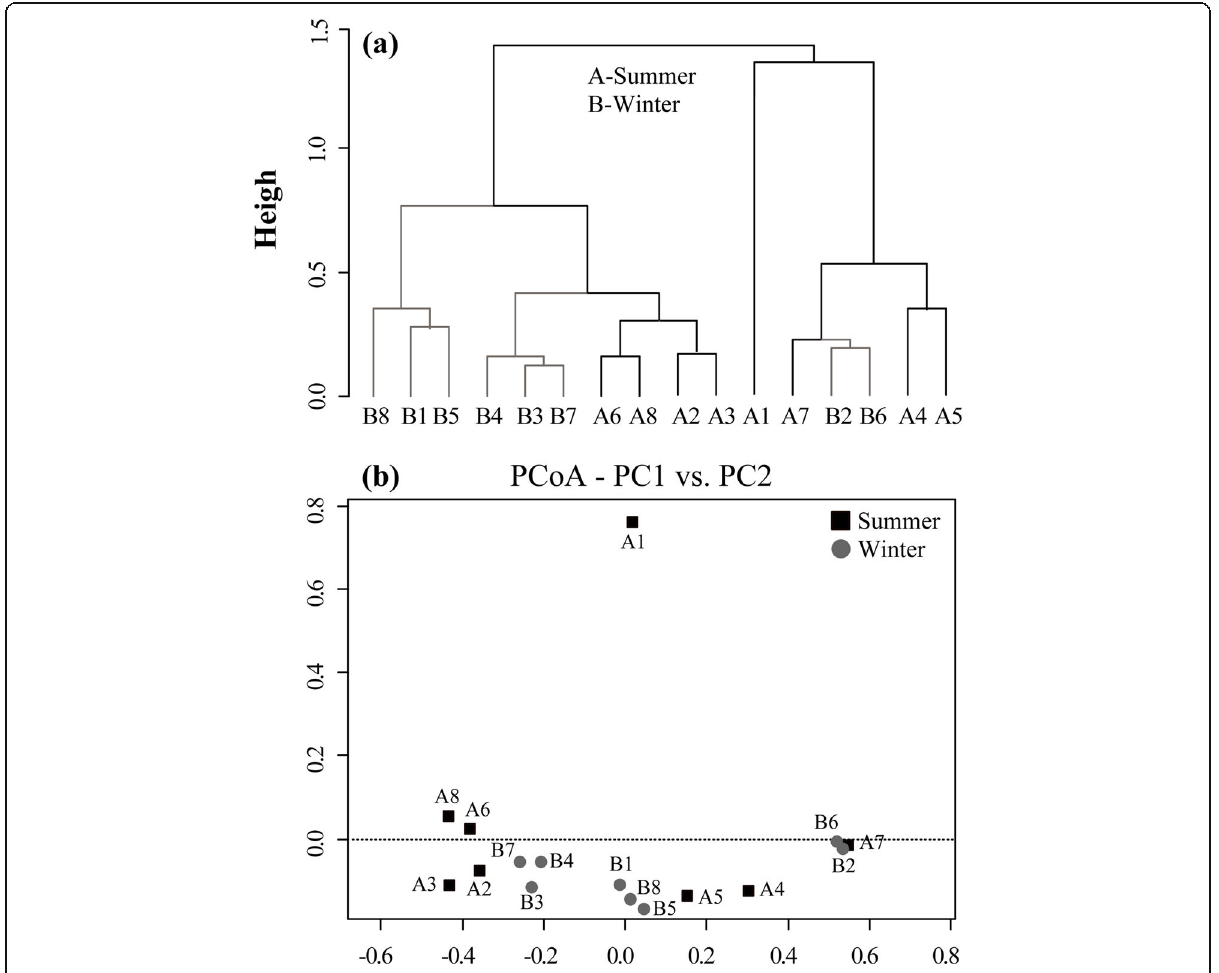
Fig. 2 a Complete cluster analysis showing the differences in the 16S rRNA genes between summer and winter based on Bray Curtis distance. b Principal coordinate analysis (PCoA) for 16S rRNA gene assemblages using Bray Curtis distance. Bray Curtis distances were calculated using the relative abundance of the genes. The letter A represents 16S rRNA genes in summer, and the letter B represents the genes in